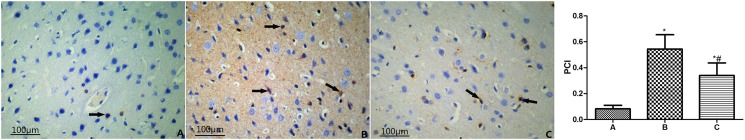
The expression of pERK1/2 in cortex of rats,DAB×400.A. Control Group; B. Model group; C. Treatment group; →. Positive cells * P<0.05, compared with control group; #P<0.05, compared with model group